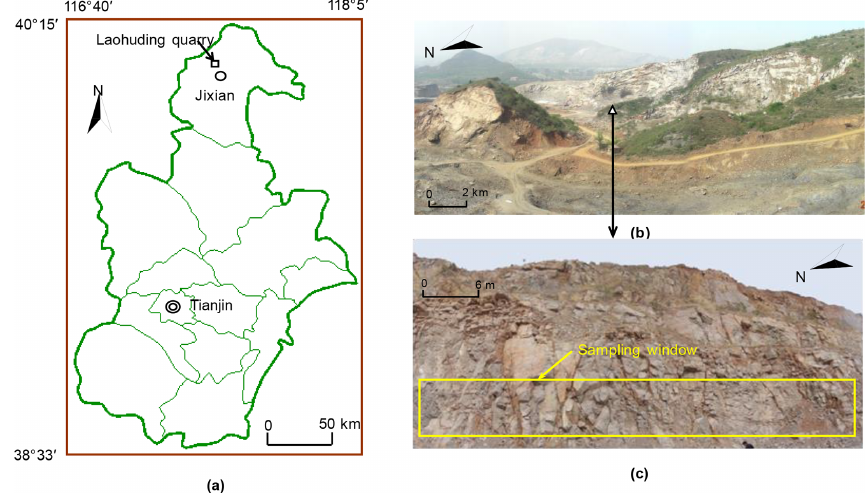
Figure 1. Location of the Laohuding Quarry and investigated rock slope. (a) Location of Laohuding Quarry in Tianjin city, China; (b) image of Laohuding Quarry and the location of the investigated rock slope; (c) image of the investigated rock slope with a strike of 200 ◦